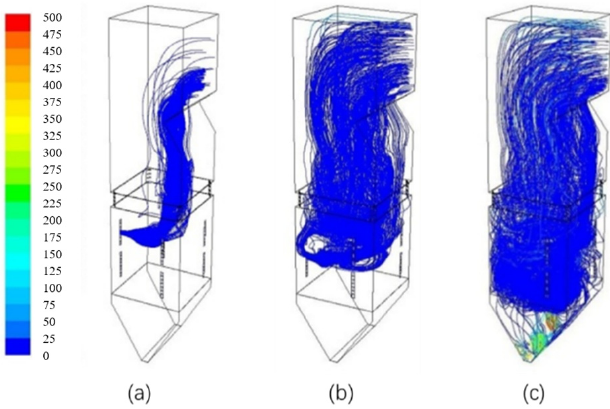
Figure 4. The trajectory of pulverized coal particles. ( a ) B layer; ( b ) D layer and ( c ) F layer.